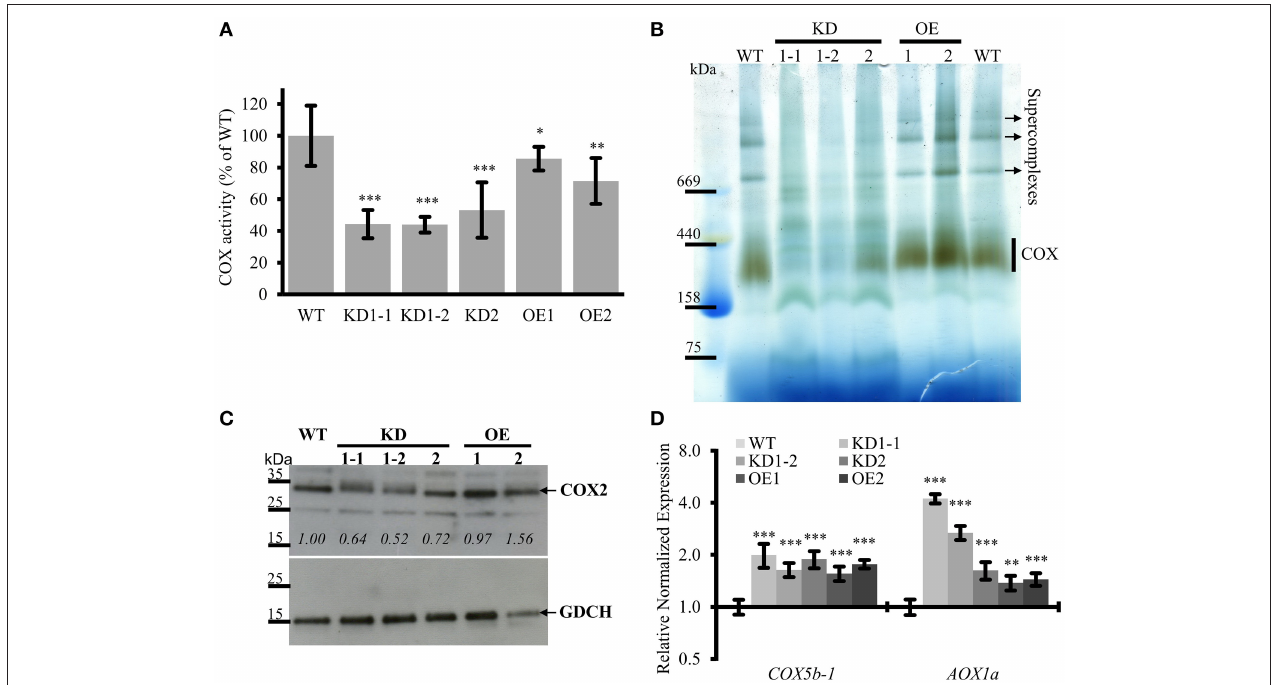
FIGURE 6 | COX complex activities are reduced in COX11 KD and OE mutants. (A) COX activities in KD and OE mutants and the WT were measured in three independent mitochondria isolations (each in technical triplicate) and normalized to the WT ( = 100%). Asterisks indicate statistical significance calculated with the Student’s t -test ( * P < 0.05 ; ** P < 0.01 ; *** P < 0.001 ). Error bars represent ± SD. (B) Mitochondrial complexes from COX11 KD, OE and WT plants were separated by gradient BN-PAGE and subsequently stained in gel for COX complex activity visible as a brown precipitate. For WT, 100 µ g of crude mitochondria was loaded, while for the mutants amounts were adjusted (based on citrate synthase activity) to compensate for contaminations. (C) Total leaf proteins from WT, KD, and OE plants (6 weeks old) were analyzed by Western blotting, using antibodies against COX2 (theoretical molecular weight of 30kDa). The membrane was stripped and subsequently incubated with antibodies against GDCH (theoretical molecular weight of 16kDa) as a loading control. In this experiment T4-generation KD1-1 plants were used (Supplementary Figure 2B). Values in italics indicate estimated COX2 abundance after densitometry analysis and normalization to GDCH amounts. (D) qPCR analysis of indicated transcript levels in WT and COX11 mutants. RNA was isolated from 14-day-old seedlings cultured on selective (KD mutants) or non-selective MS (WT) plates. Mean values of mRNA levels in COX11 mutants were normalized to WT and plotted on a logarithmic scale (base two). Values and statistical significance (compared with the WT, ** P < 0.01 , *** P < 0.001 ) were calculated with the CFX manager software. Error bars represent ± SD. All individual values are listed in Supplementary Table